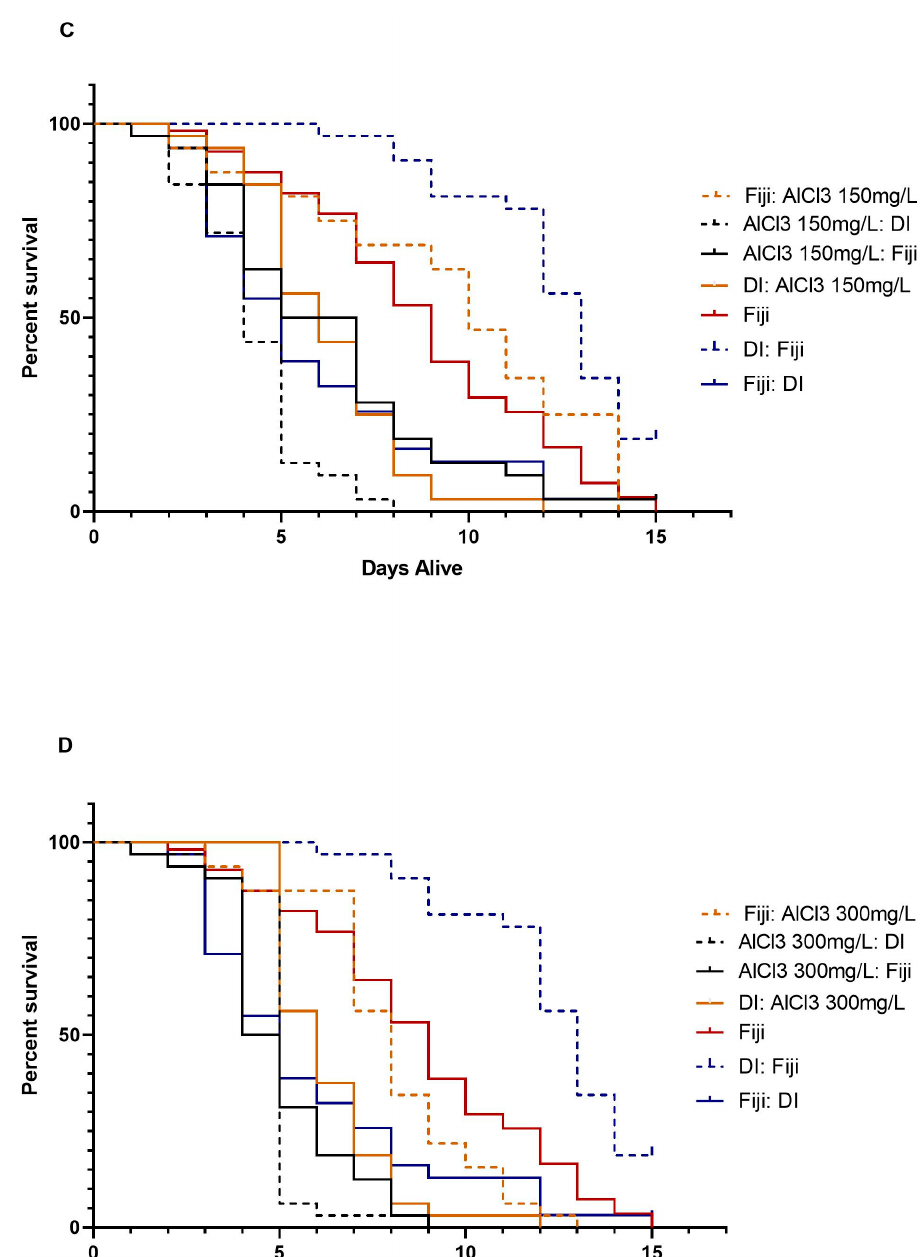
Figure 3. Survival curve for experimental honey bees by aluminum concentration. ( A ) Days alive for AlCl3 25 mg and respective control group bees. ( B ) Days alive for AlCl3 75 mg/L and respective control group bees. ( C ) Days alive for AlCl3 150 mg/L and respective control group bees. ( D ) Days alive for AlCl3 300 mg/L and respective control group bees.